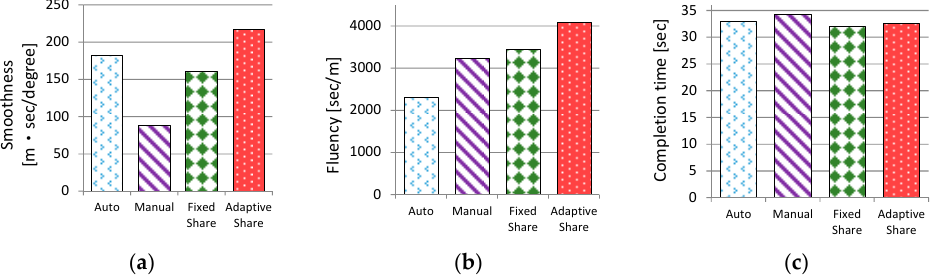
Figure 10. Experimental results of the skill-based error operation in terms of the three criteria. ( a ) Smoothness ( b ) Fluency, ( c ) Completion time.